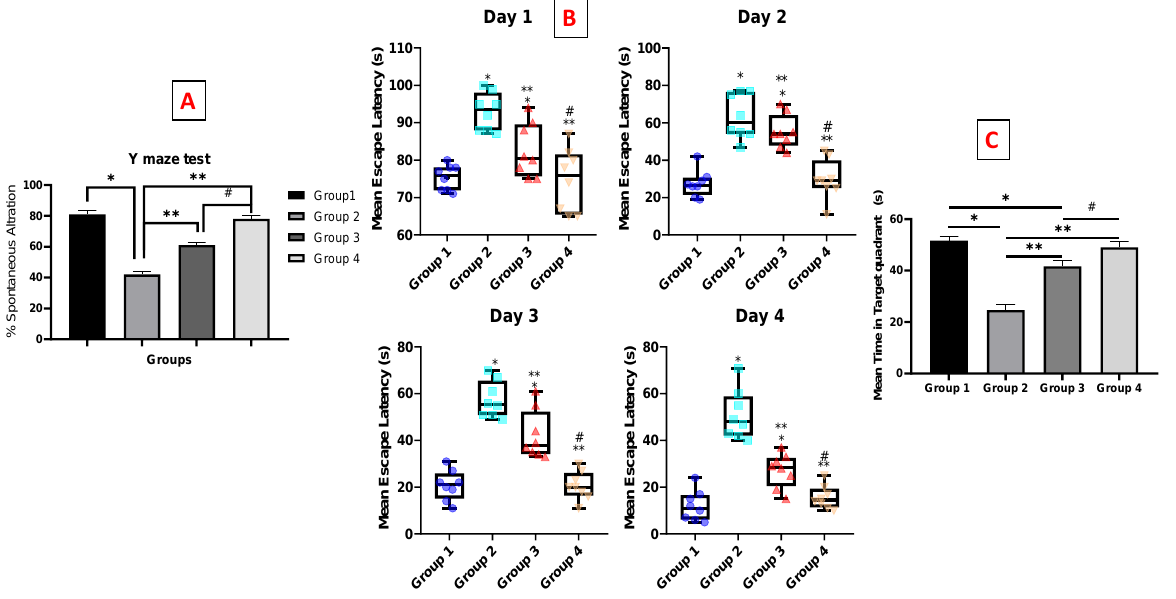
Figure 4. Behavioral tests on effect of luteolin-chitosomes on ICV-STZ mouse model. Animals were divided into 4 groups, eight animals in each group (n = 8), the first one was the normal control group. The second group was the positive control group that received STZ (3 mg/kg, ICV). The last two groups were all ICV-injected, first with STZ (3 mg/kg) followed by intranasal administration of luteolin suspension (50 mg/kg, every day for 21 days) and luteolin-loaded chitosomes (50 mg/kg, i.n. for 21 days) respectively. ( A ) Y-maze test that measured the percentage of spontaneous alternation, ( B ) box and whisker plots of mean escape latency (MEL), and ( C ) mean time in target quadrant. Statistical analyses for the Morris water maze test (escape latency) were analyzed using two-way repeated measures ANOVA. The data that were not included in repeated measures were analyzed with one-way ANOVA followed by the Tukey post-hoc test for multiple comparisons. Each value was expressed as mean ± SD. *: Statistically significant different from the normal group at p < 0.05, **: Statistically significant different from the positive control group (STZ, 3 mg/kg) at p < 0.05. #: Statistically significant different from the luteolin suspension group (50